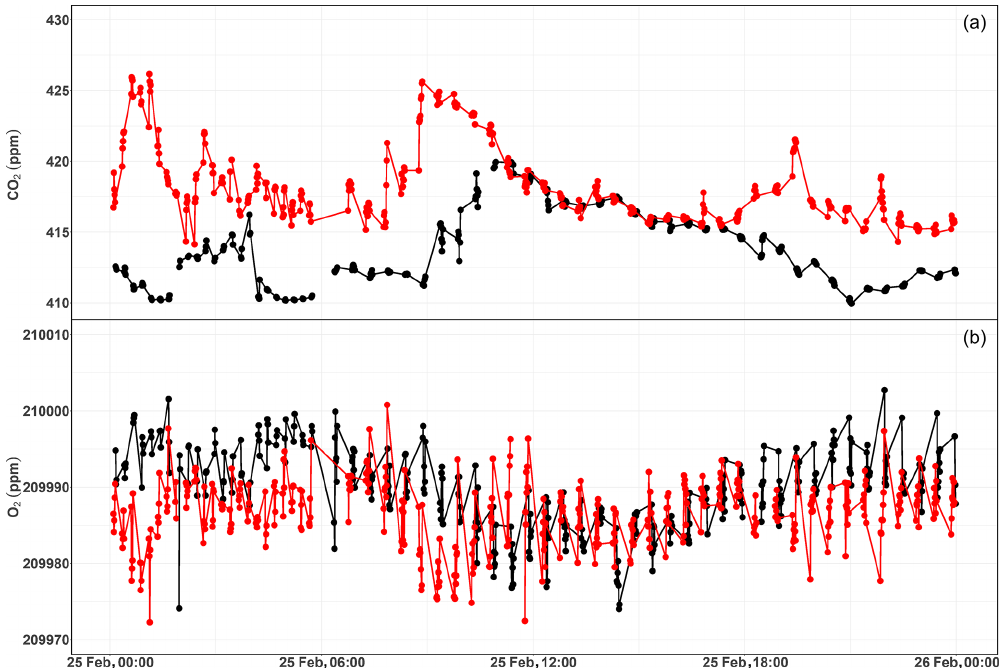
Figure 17. Diurnal variations of CO 2 (a) and O 2 (b) measurements from the 12m (red) and the 212.5m (black) height levels at Beromünster